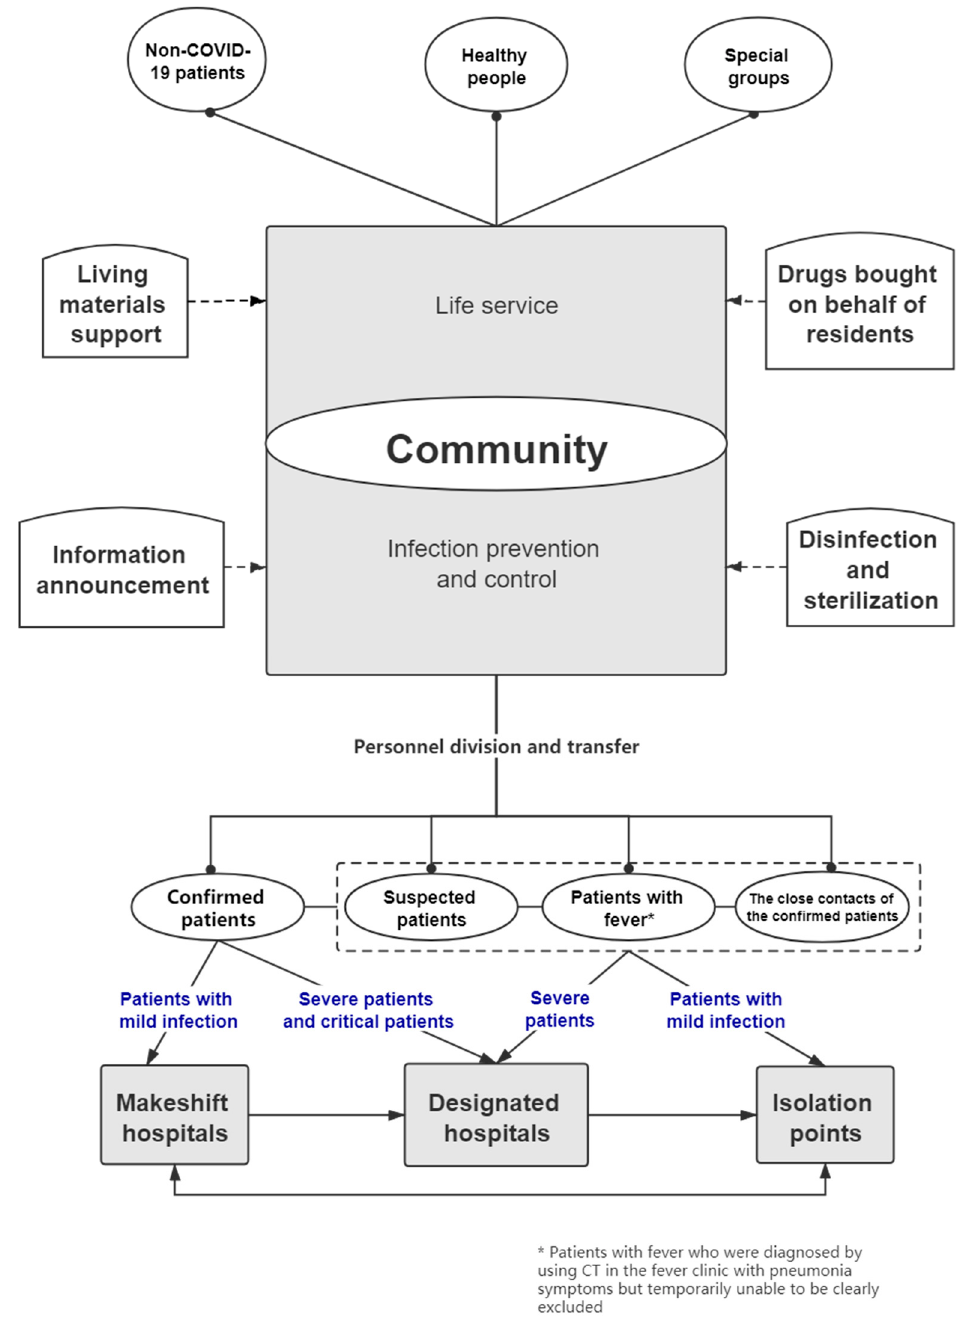
Figure 1. Schematic diagram of the streaming process from the community to different types of hospitals of different types of patients.